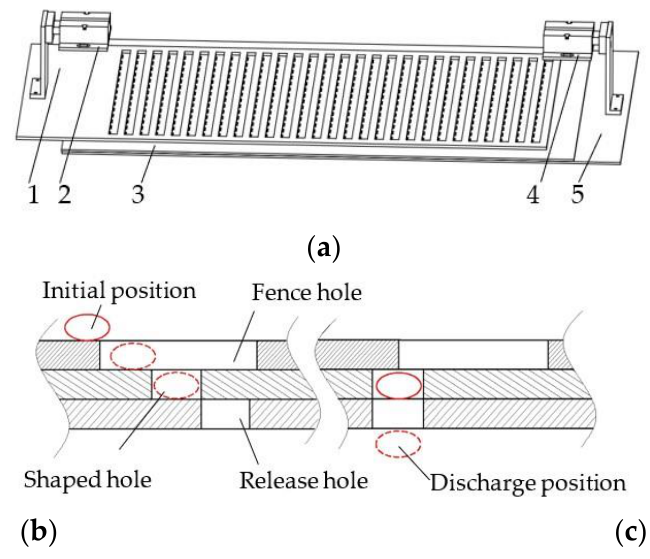
Figure 6. Schematic diagram of connection principle of filling and discharging seeds: ( a ) Structural diagram of filling and metering cycle connection; ( b ) Seed filling state; ( c ) Seed metering state. 1. Upper plate; 2. First cylinder; 3. Bottom plate of the seed filling box; 4. Second cylinder; 5. Lower plate.